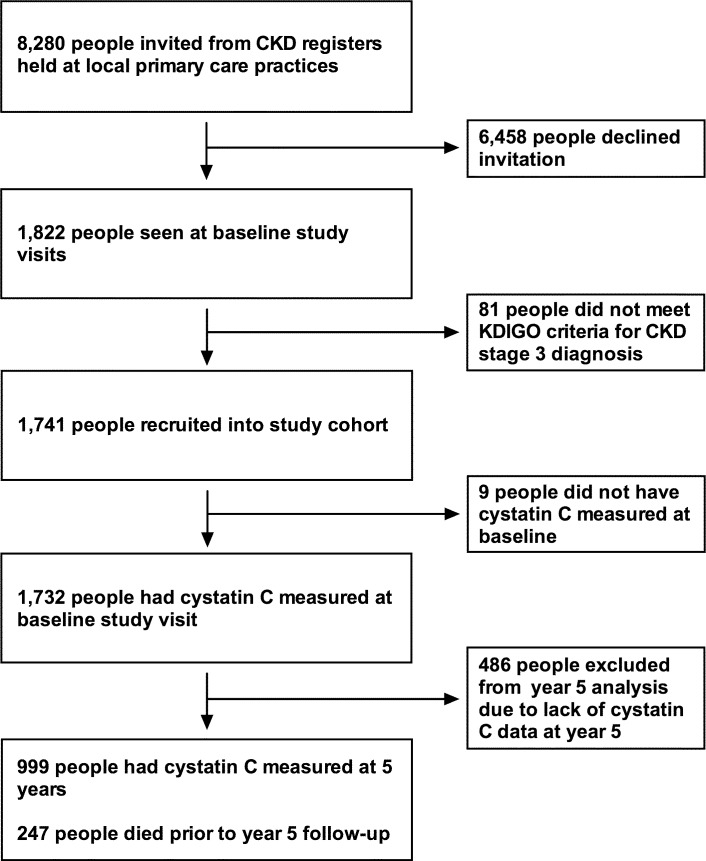
Flow chart for participants invited and recruited into the study, and numbers involved at key time points.CKD, chronic kidney disease; KDIGO, Kidney Disease Improving Global Outcomes.